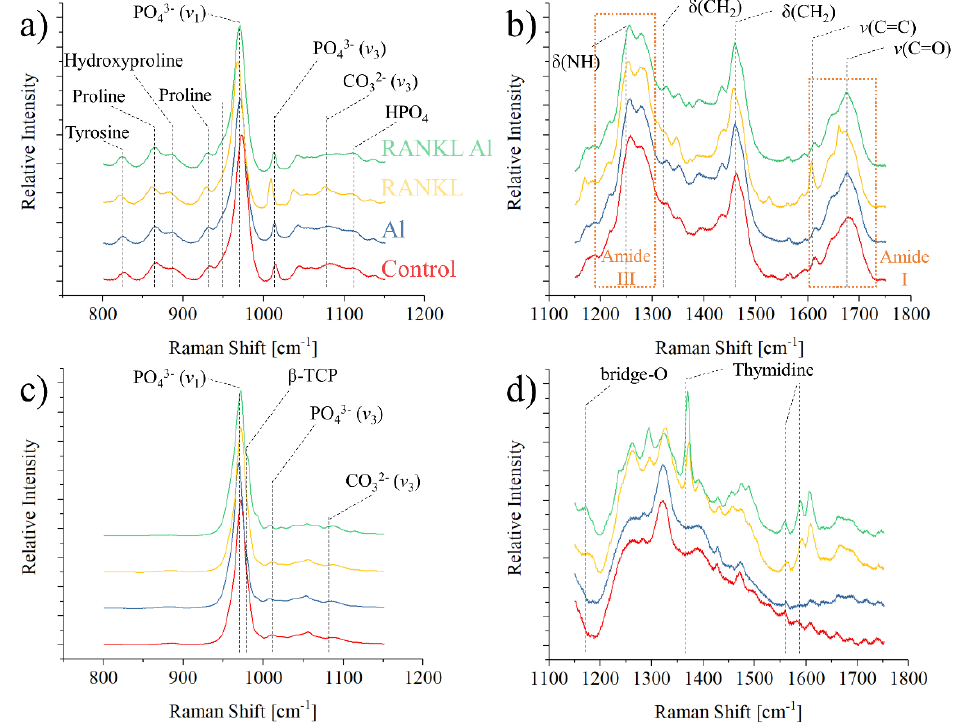
Figure 8. Average Raman spectra collected on the surface of the samples. ( a ) Dentine hydroxyapatite region, ( b ) dentine amides region, ( c ) octacalcium phosphate hydroxyapatite region and ( d ) octacalcium phosphate amides region.